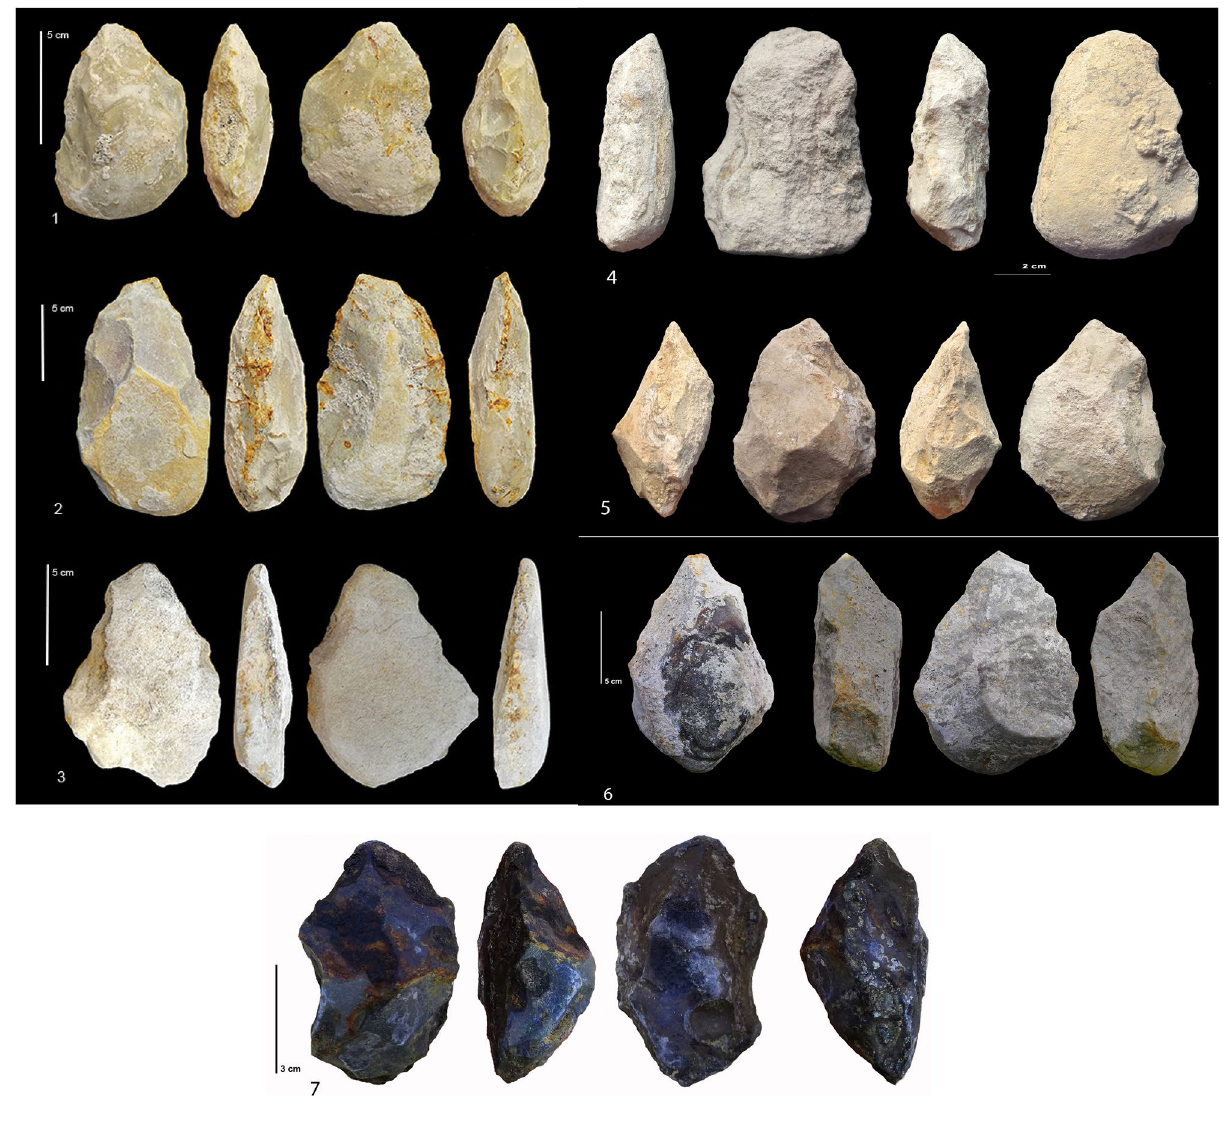
Figure 5. Layer F. Bifaces and bifacial tools on limestone pebbles ( 1 – 6 ). Bifacial tool on a large chert nodule. Four bifaces on limestone and large chert nodules were found among the ten Large Cutting Tools